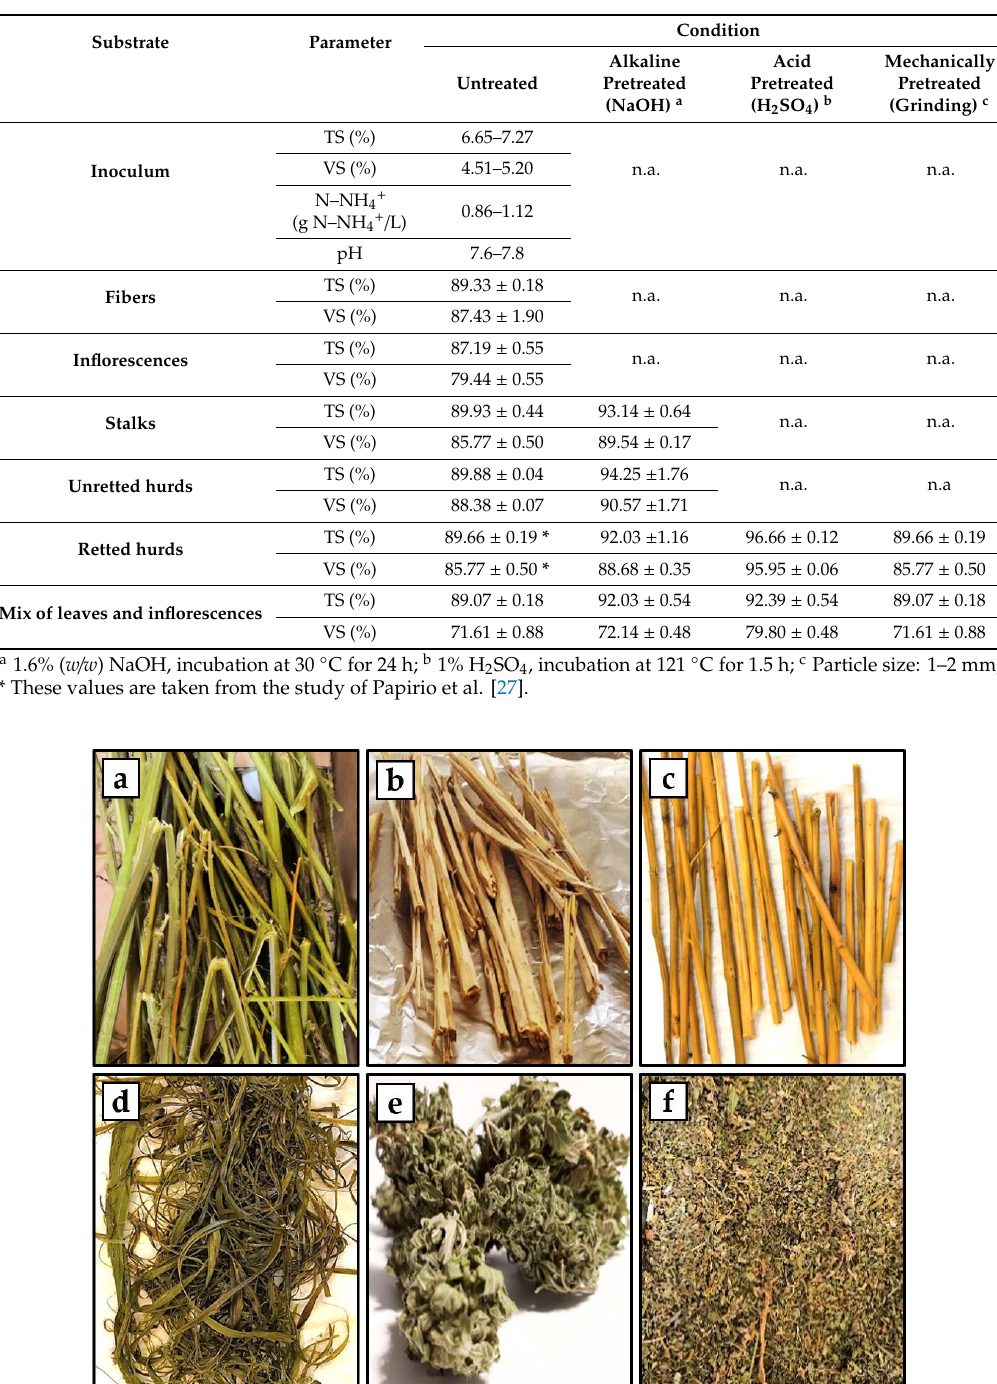
Table 1. Characterization of the anaerobic inoculum and the untreated and pretreated HBRs. TS: total solids; VS: volatile solids; N–NH 4 + : ammonium nitrogen. Values for the inoculum are given as the range of the mean values measured on the anaerobic digestate used for the biochemical methane potential (BMP) tests. Values for the HBRs are expressed as the mean and standard deviation calculated on three replicates.